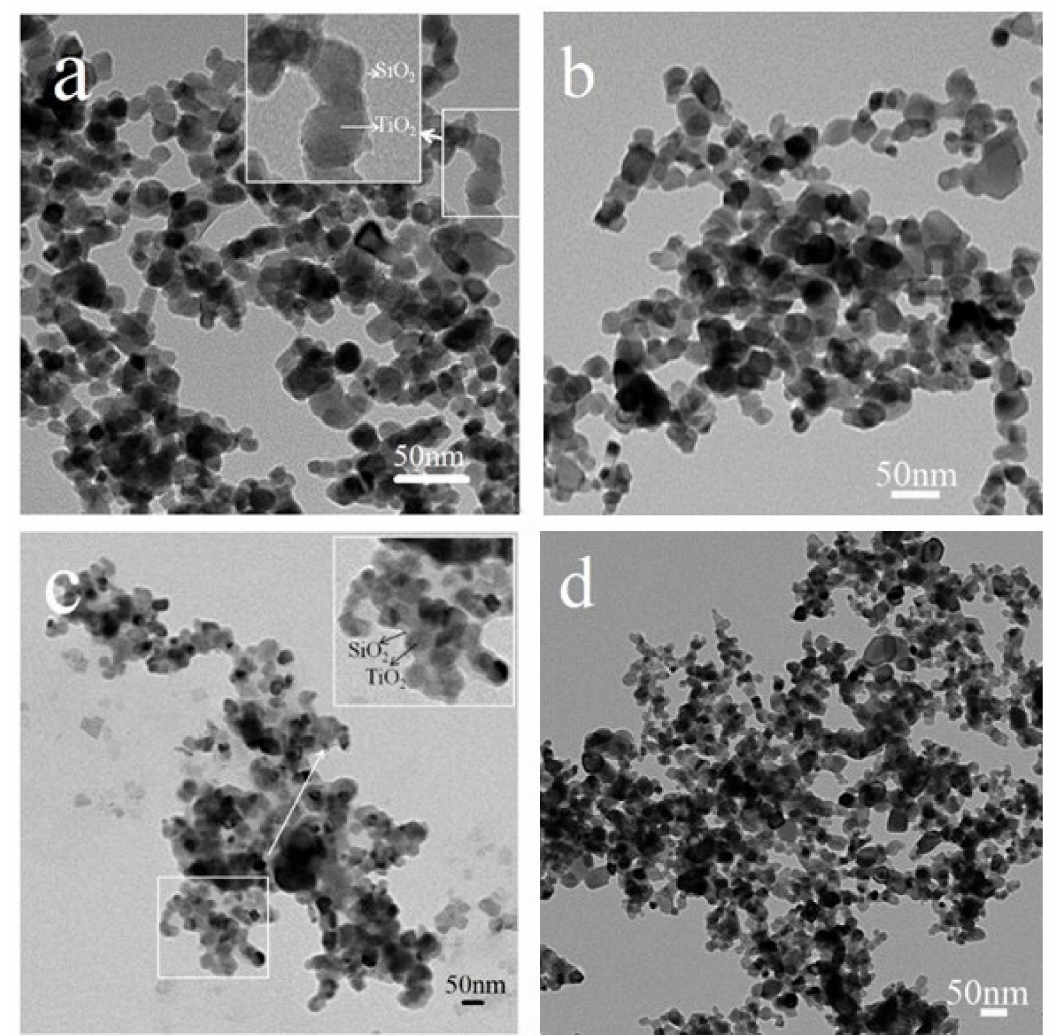
Figure 1. TEM images of Sample 1 ( a ), Sample 3 ( b ), Sample 4 ( c ), and Sample 6 ( d